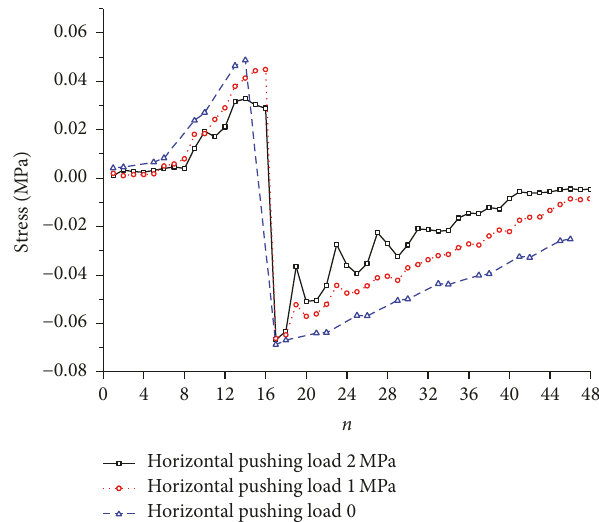
Figure 11: Stress evolution process of monitoring points at different horizontal pushing load.